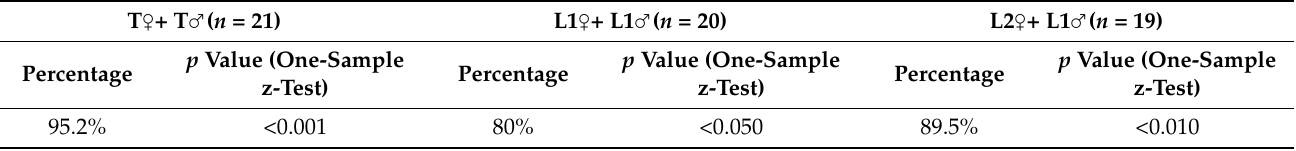
Table 8. Percentage of cases when males exhibited identification behaviour during